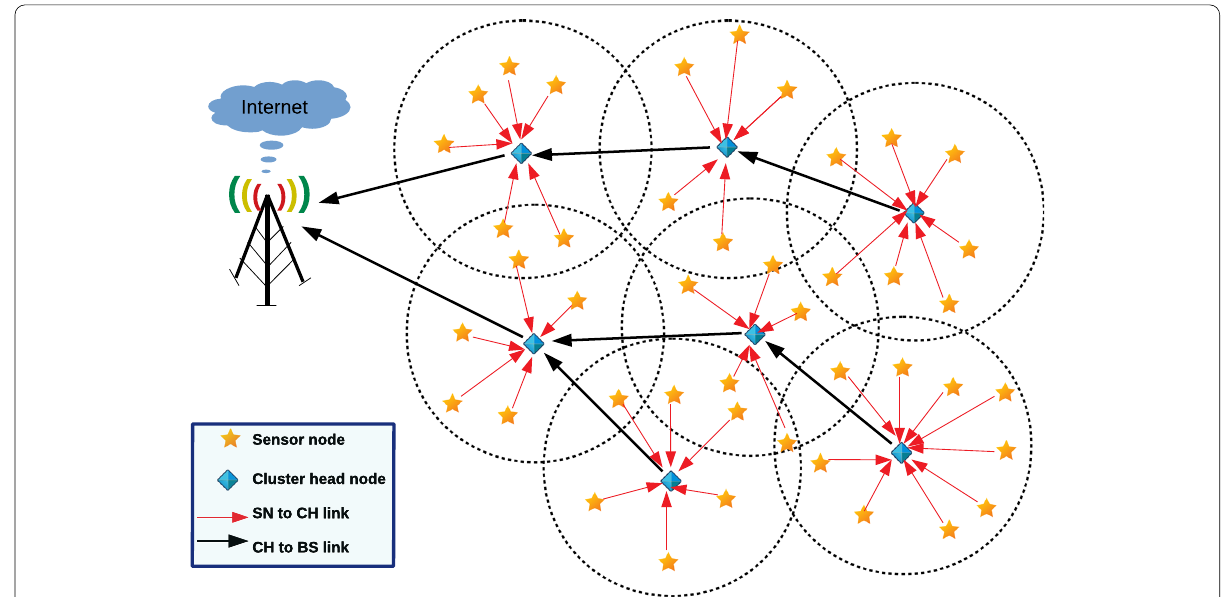
Fig. 1 Conceptual representation of